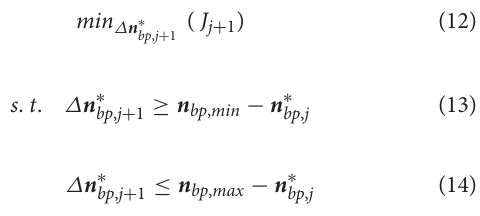
FIGURE 3 | Reference PF trajectories that incorporate a physiological response to preload changes based on the Frank-Starling mechanism and therapy-oriented pulsatile PF profiles. A copulsation and a counterpulsation PF trajectory along with the LVP for one cardiac cycle are depicted. For both PF trajectories, the minimum PF is q * bp , min = 20 mL / s and the maximum PF is calculated based on the q * bp , min and the necessary average PF provided by the starling-relation ( ¯ q * bp ). PF, pump flow; LVP, left ventricular pressure; Co-PF, copulsation pump flow; Counter-PF, counterpulsation pump flow.